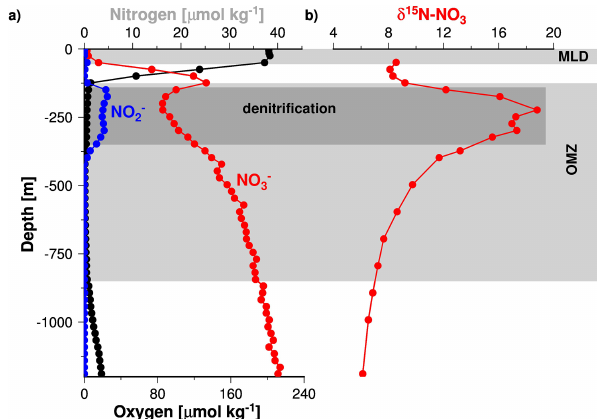
Figure 7. Vertical profiles of nitrite, nitrate, and dissolved oxygen (a) as well as δ 15 N of nitrate (b) measured during the RV Me- teor cruise M74/1b in 2007. The figure was obtained from Rixen et al.